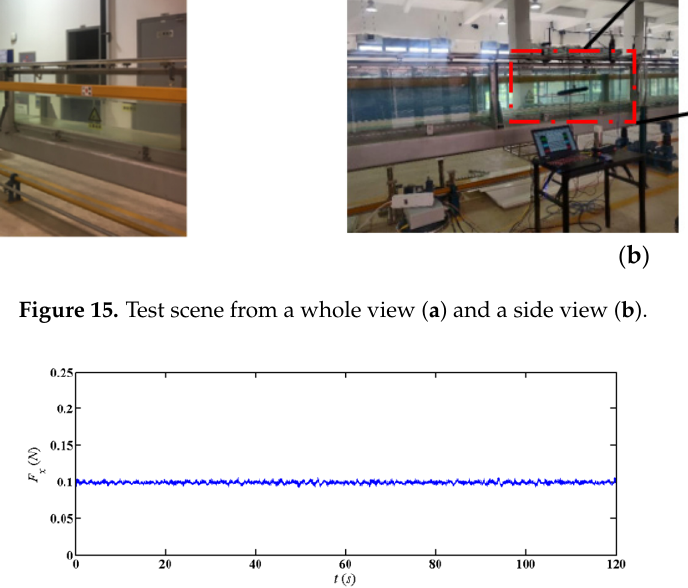
Figure 16. Measurement results after smoothing fi ltering ( α = 0°).